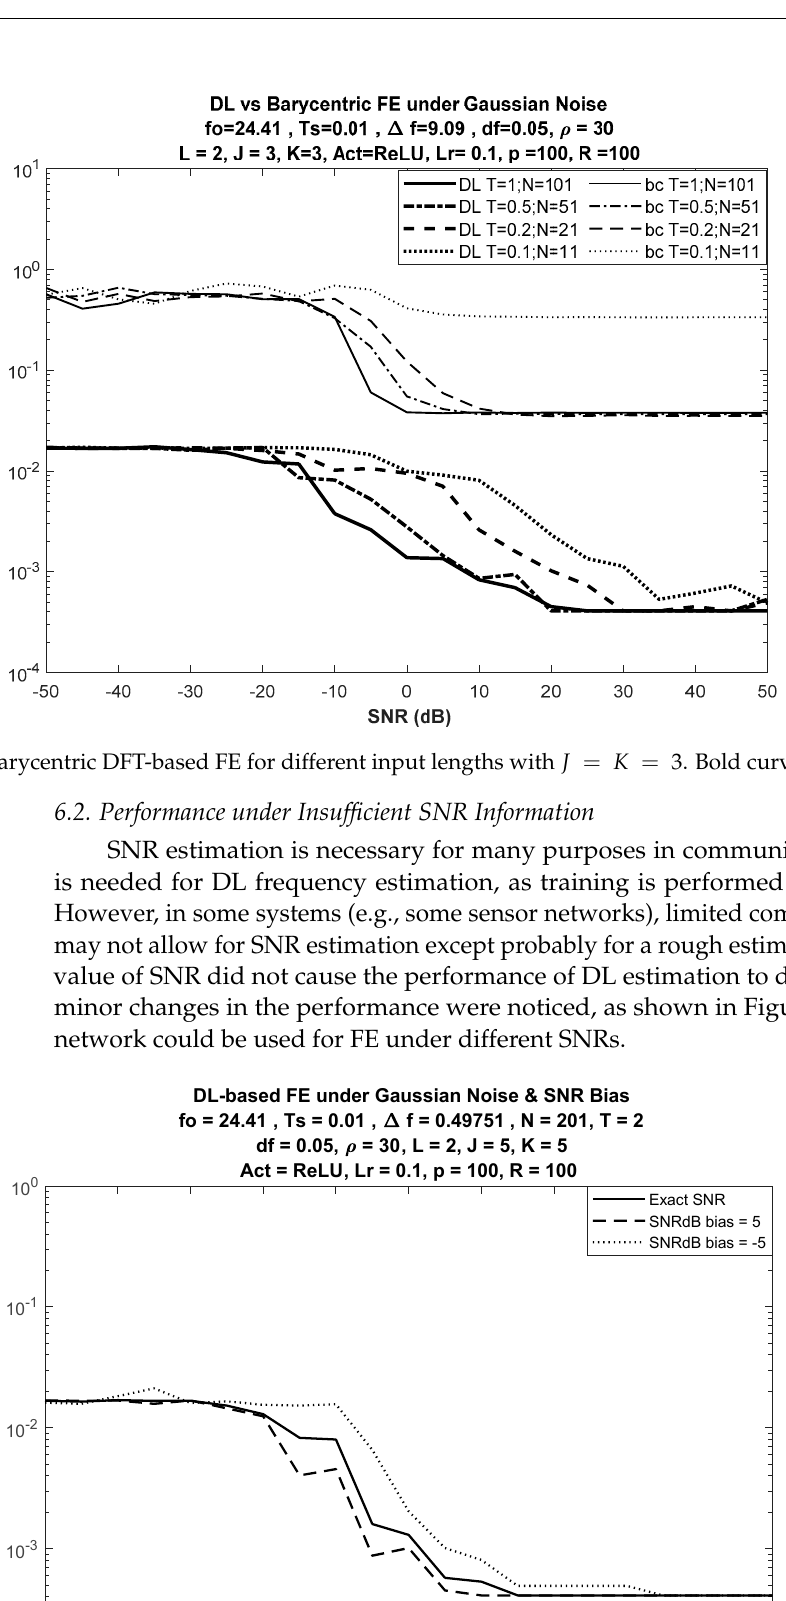
Figure 3. DL vs. barycentric discrete Fourier transform (DFT)-based FE for different input lengths with (cid:1836) = (cid:1837) = 5 . Note that DFT-based FE failed when (cid:1840) = 11 , while DL-based FE gave reasonable results even at low signal-to-noise ratio (SNR).